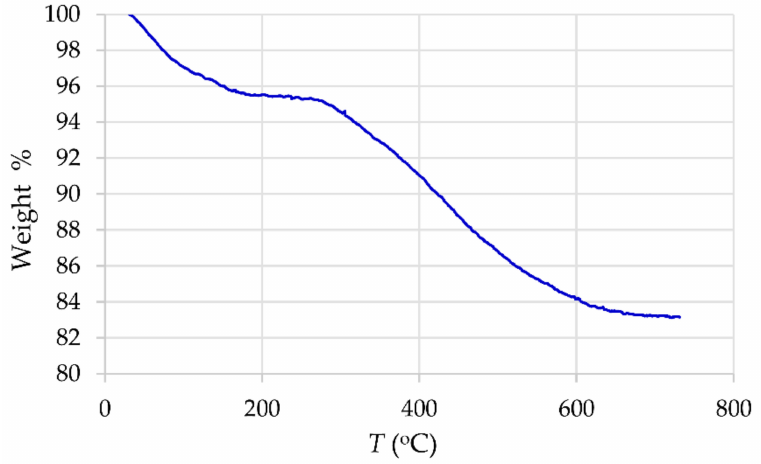
Figure 4. Thermogravimetric analysis (TGA) for γ -Fe 2 O 3 -NH 4 OH@SiO 2 (APTMS)